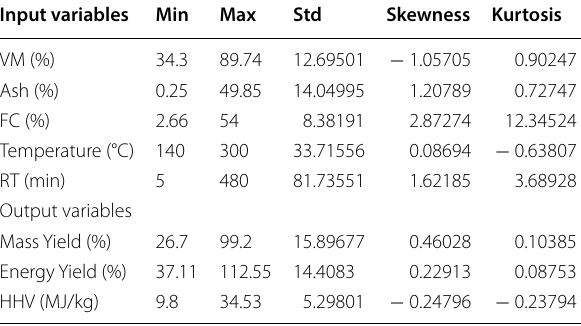
VM Volatile matter, FC fixed carbon, HHV high heating value, RT residence time